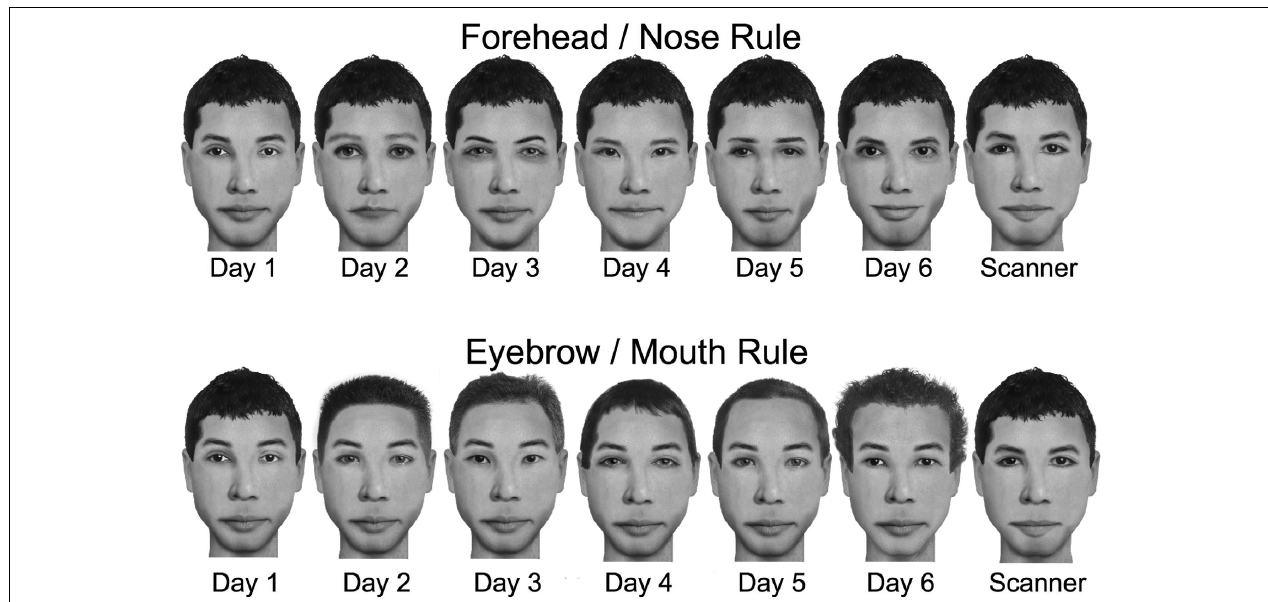
FIGURE 2 | Different template faces were used for each day of training. For the forehead/nose task, eyes, eyebrows, and mouth changed day to day whereas the hair, nose, ears, and jaw were constant. For the eyebrow/mouth task, hair and eyes changed day to day whereas the eyebrows, mouth, nose, ears and jaw were